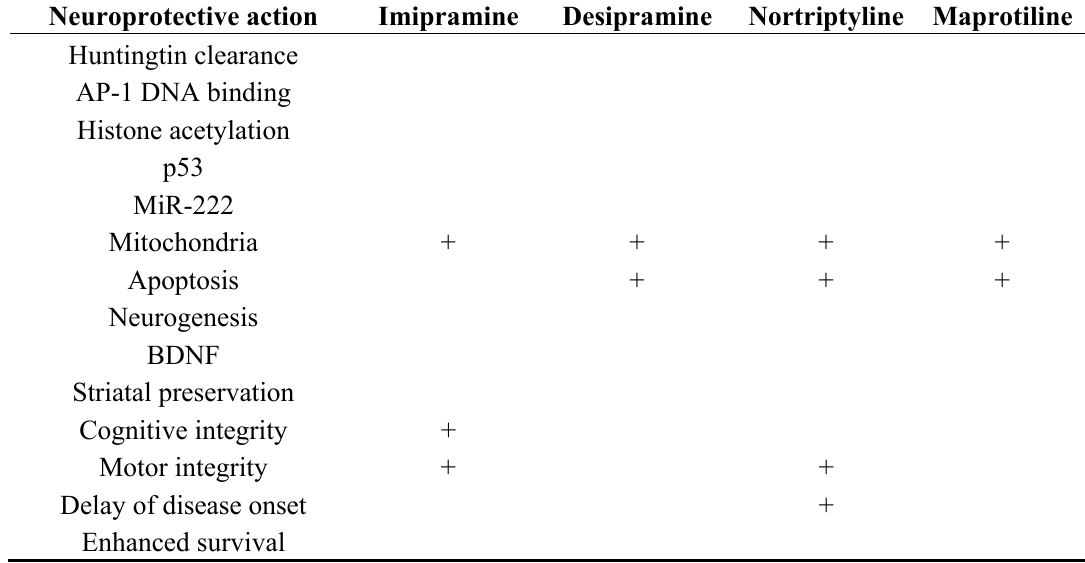
Table 7. Tricyclic and tetracyclic antidepressant neuroprotective effects in Huntington’s disease